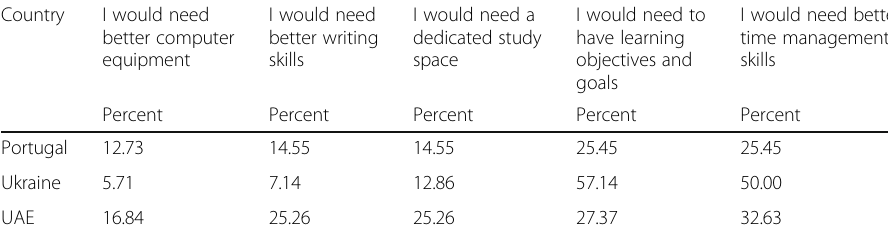
Table 7 Preparation students feel they need before enrolling in distance education courses (More than one could be chosen)